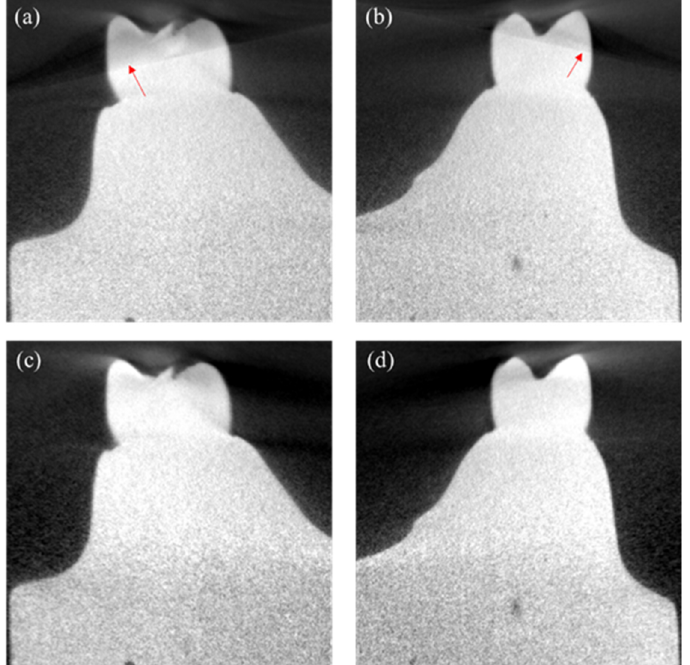
Figure 6. ( a , b ) show two regions of interest in the images reconstructed by the FDK algorithm. ( c , d ) show the corresponding regions in the images reconstructed by the CW-FDK algorithm. We can see that the cone-beam artifacts (indicated by the red arrow) have been much reduced in the images of the CW-FDK algorithm.